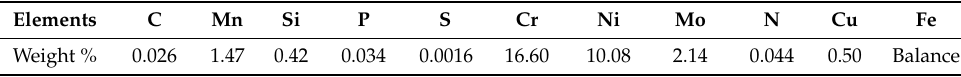
Table 1. Chemical composition of 316L stainless